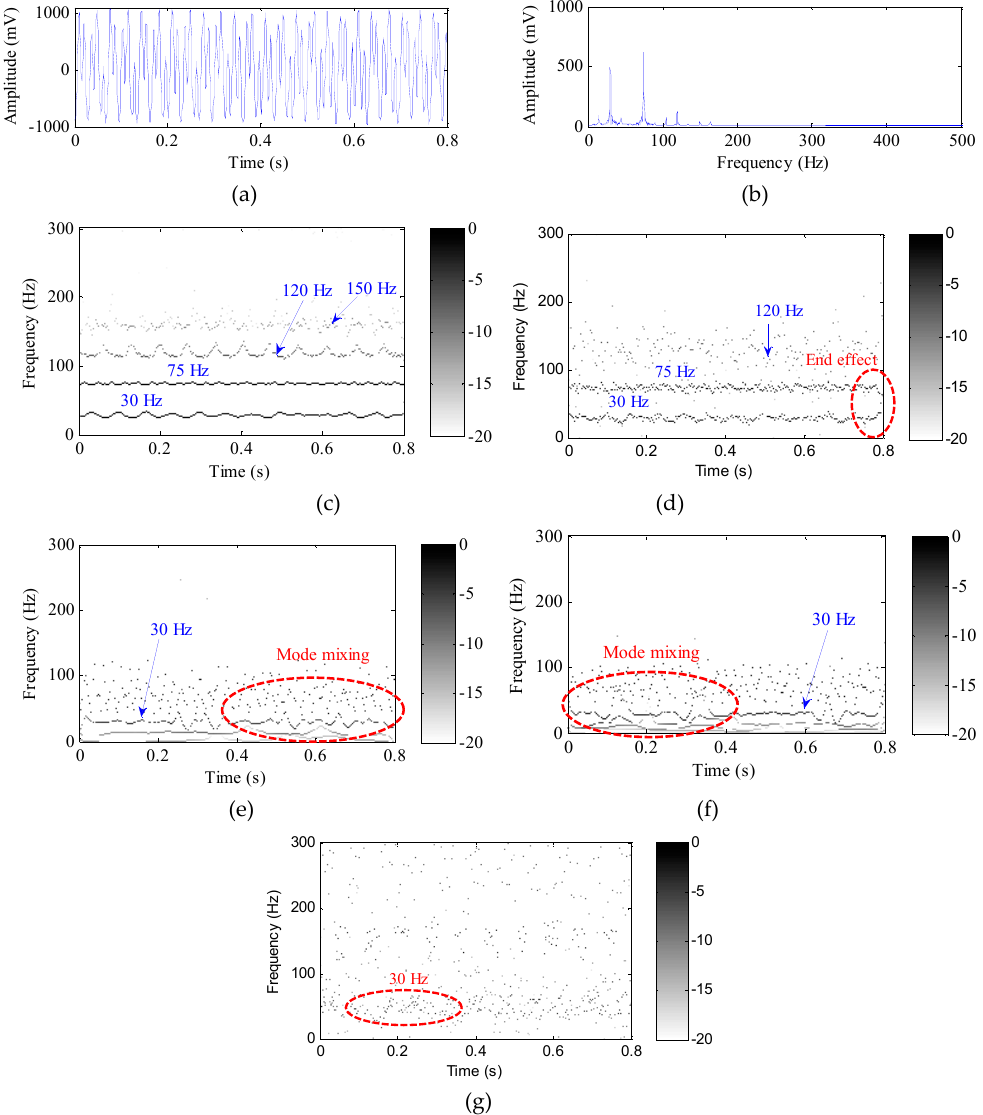
Figure 20. The analyzed results of the rotor oil-whip signal: ( a ) Temporal waveform, ( b ) FFT spectrum, time-frequency representations obtained by ( c ) IAVMD, ( d ) OVMD, ( e ) LMD, ( f ) EMD, and ( g ) WT.